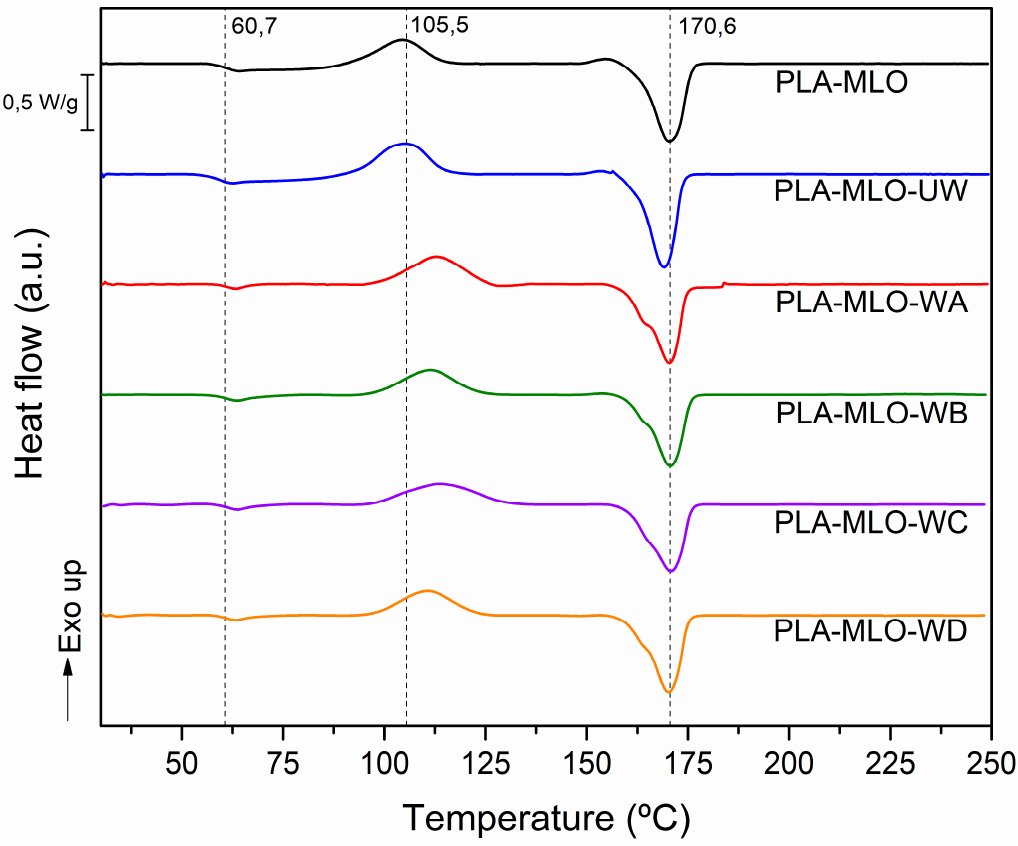
Figure 7. Differential scanning calorimetry (DSC) thermograms of PLA–wool FRP studied, the main transition temperatures are specified.